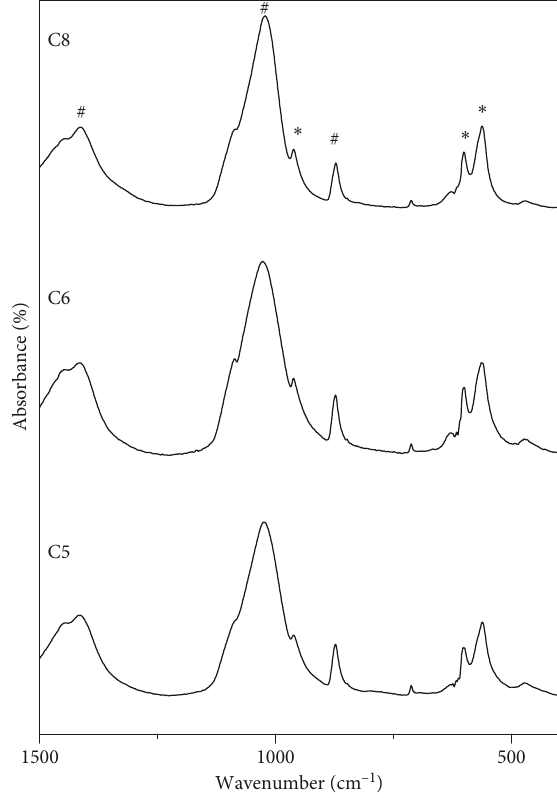
Figure 5: Infrared spectra of bone samples analyzed. Results of the samples from the layers C1, C2, C3, and C4, where peaks of hy- droxyapatite ( ∗ ) (Ca 10 (OH) 2 (PO 4 ) 6 ) and calcite (#) (CaCO 3 ) are